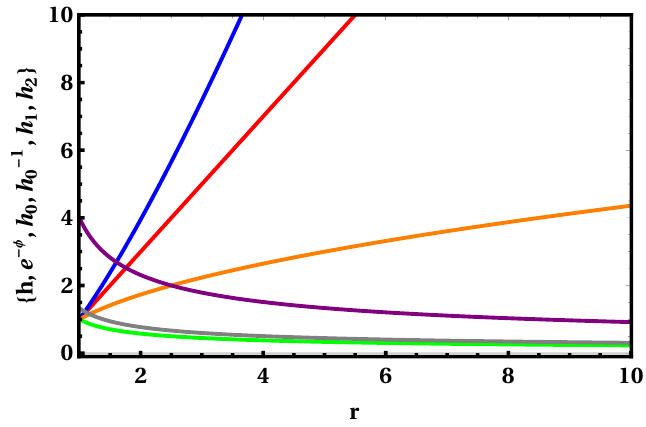
Figure 1 . The h -function, the dilaton and the various warp factors of the metric (3.1) in the massive IIA theory that realizes large N = (4 , 0) superconformal symmetry. We use the language of eq. (2.6) and we are showing the h -function which is the red line, the dilaton e − φ is te blue line, the green and orange lines are the h and 1 /h factors respectively, and finally the h and h warp 0 0 1 2 factors are represented by the purple and gray lines respectively. The precise numerical values are F 0 = 2 , ν = 1 , c = − 1 , L = 1 and β 1 = π/ 3